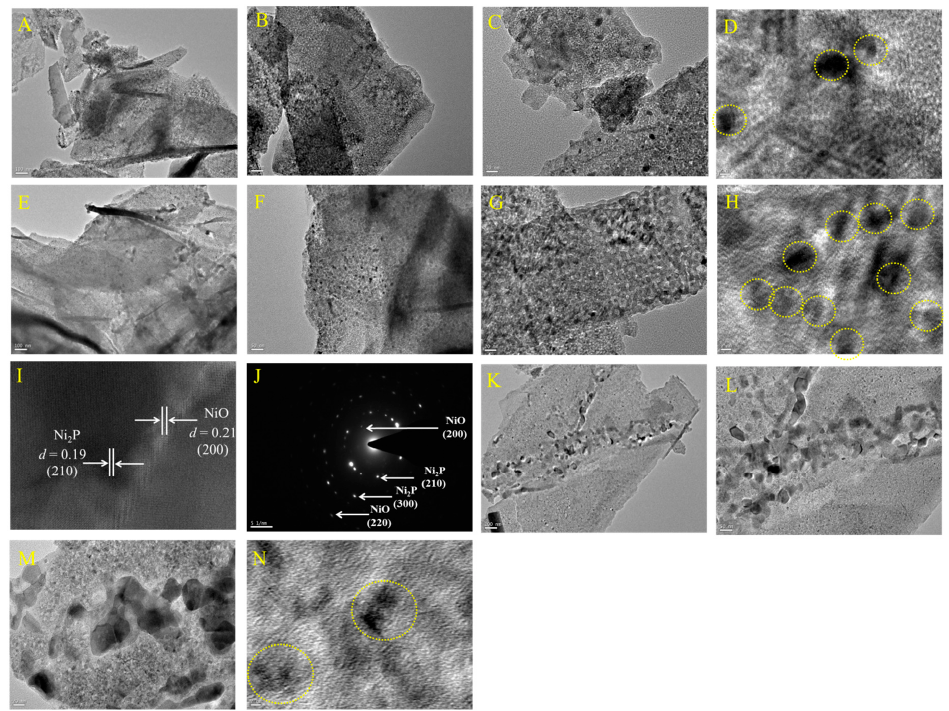
Figure 3. Low- to high-resolution TEM images showing the insertion of Ni 2 P nanoparticles on the surface of NiO/NiF wall-like networked nanosheets at different time intervals. (i) 20 min (images A – D ), (ii) 40 min images ( E – I ), corresponding selected area diffraction pattern (SAED; J ), and (iii) 60 min (images K – N ). Scale Bars: 100 nm (images A , E , K ); 50 nm (images B , F , L ); 20 nm (images C , G , M ); and 2 nm (images D , H , I , N ). Scale bar for SAED ( J ): 5